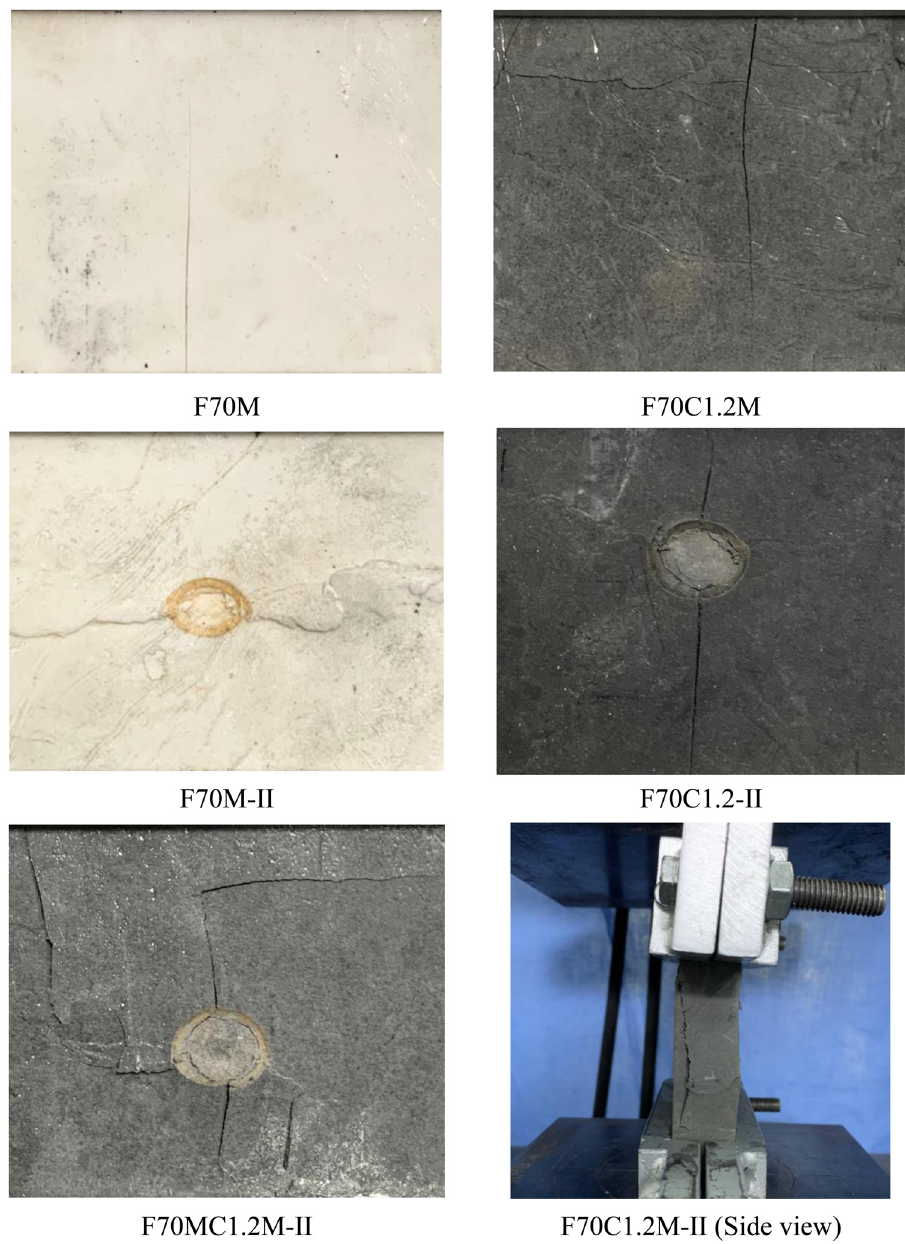
Figure 10: Edgewise compressive failure